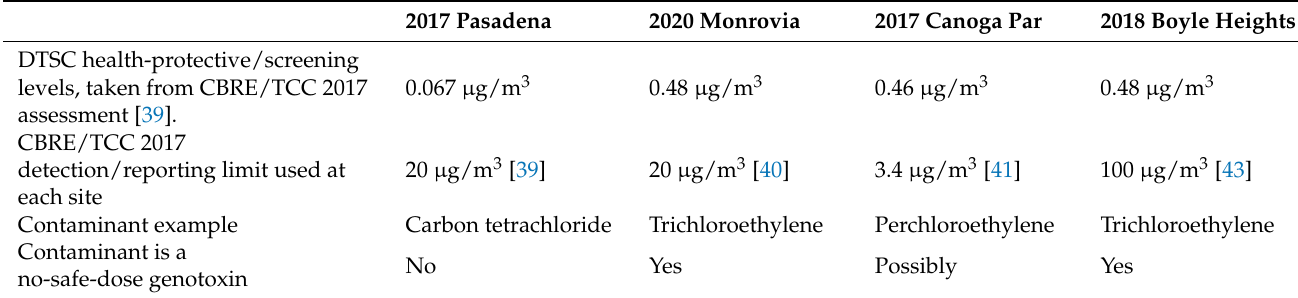
Table 4. Examples of CBRE/TCC human-carcinogen detection/reporting limits (RepQ7), 2017–2020, that are required to be as sensitive as California DTSC screening